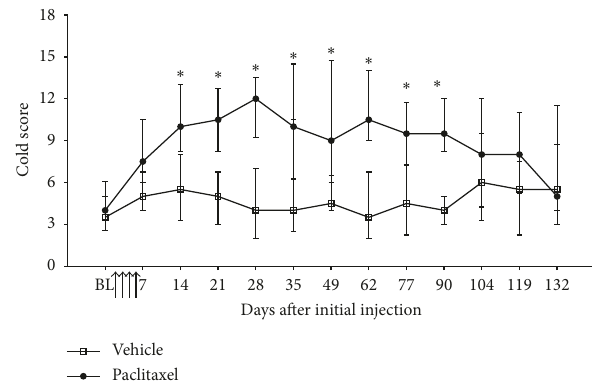
Figure 3: Time course of paclitaxel-induced cold hypersensitivity. Graph shows the median interquartile range of the hind paw response to acetone application catergorised by the cold score. BL baseline before paclitaxel/vehicle administration. Arrows in- ± (cid:31) dicate four injections of 2 mg/kg paclitaxel or equivalent volume of p vehicle on days 0, 2, 4, and 6. 0 . 05, the Friedman test with Dunn’s post hoc test comparing the baseline scores in each group ∗ ( n 12 per group). As this analysis is nonparametric, the error bars < (cid:31) appear larger than expected from parametric analysis.